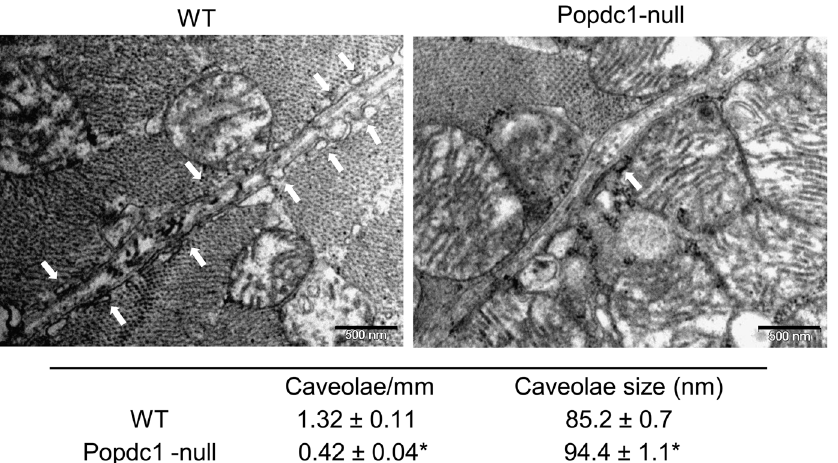
Figure 6. Caveolae are altered in Popdc1 -null hearts. Electron micrographs showing caveolae (arrows) in WT and Popdc1-null hearts. Scale bar, 0.5 m m. In the bottom panel, summary of caveolae abundance and size measured along 680 and 660 mm membrane length in WT and Popdc1-null hearts, respectively; n=3/genotype; Mean 6 SEM; *P , 0.00001.